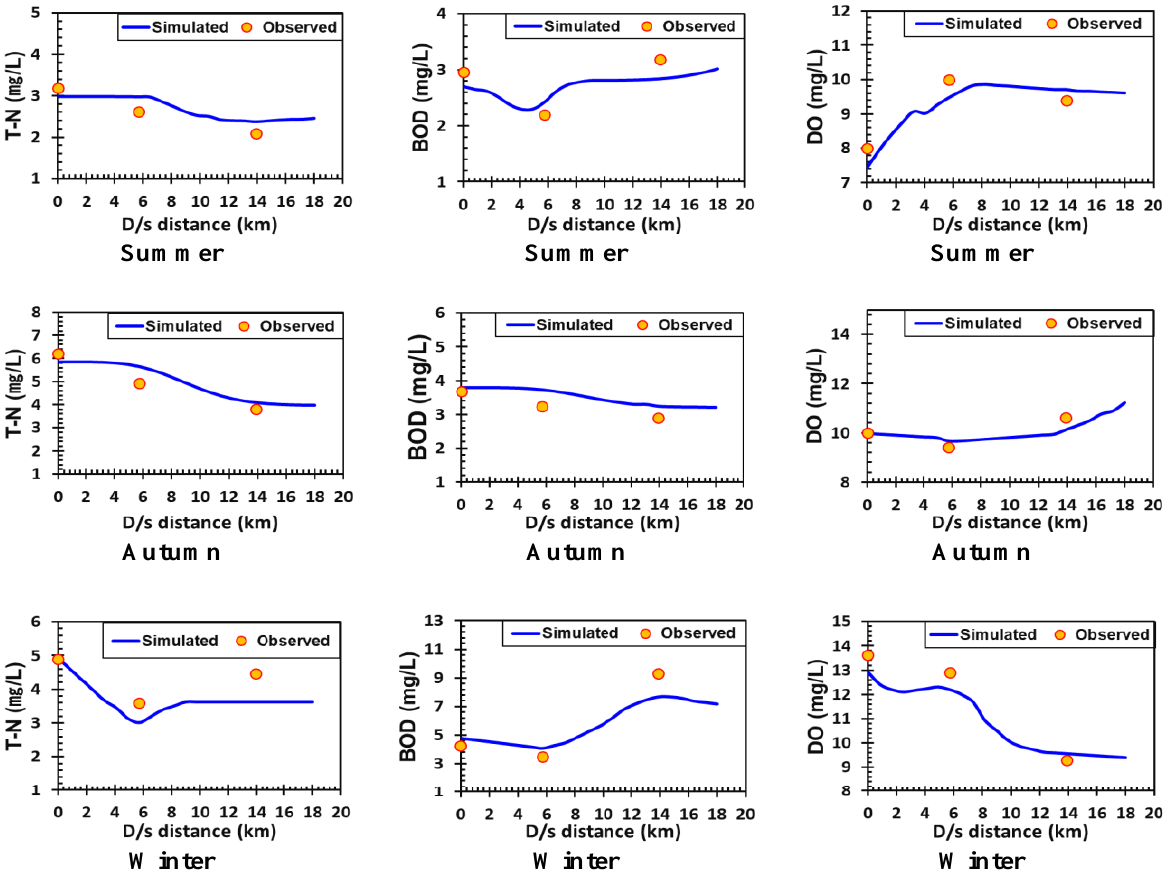
Figure 5. Confirmation of water qualities in the Ara Waterway for summer, autumn, and winter seasons.